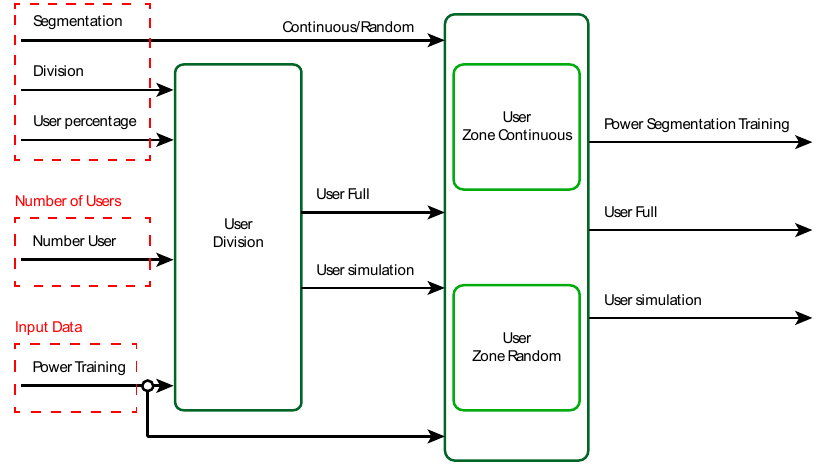
Figure 3. Functions of the collaborative model.